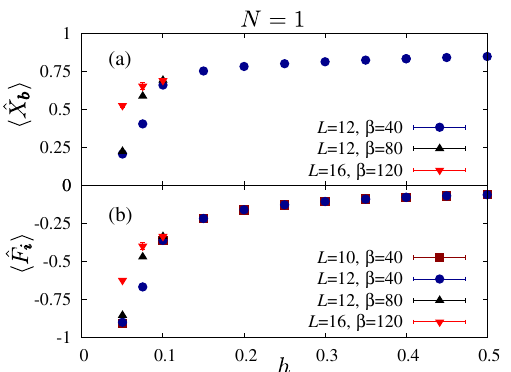
FIG. 6. (a) Size extrapolation of the charge density wave order parameter Δ performed with a second-order polynomial in CDW 1 =L . (b) Extrapolated value of Δ at different temperatures. CDW Below h ¼ 0 . 1 , our lattice sizes are too small to unambiguously extrapolate to the thermodynamic